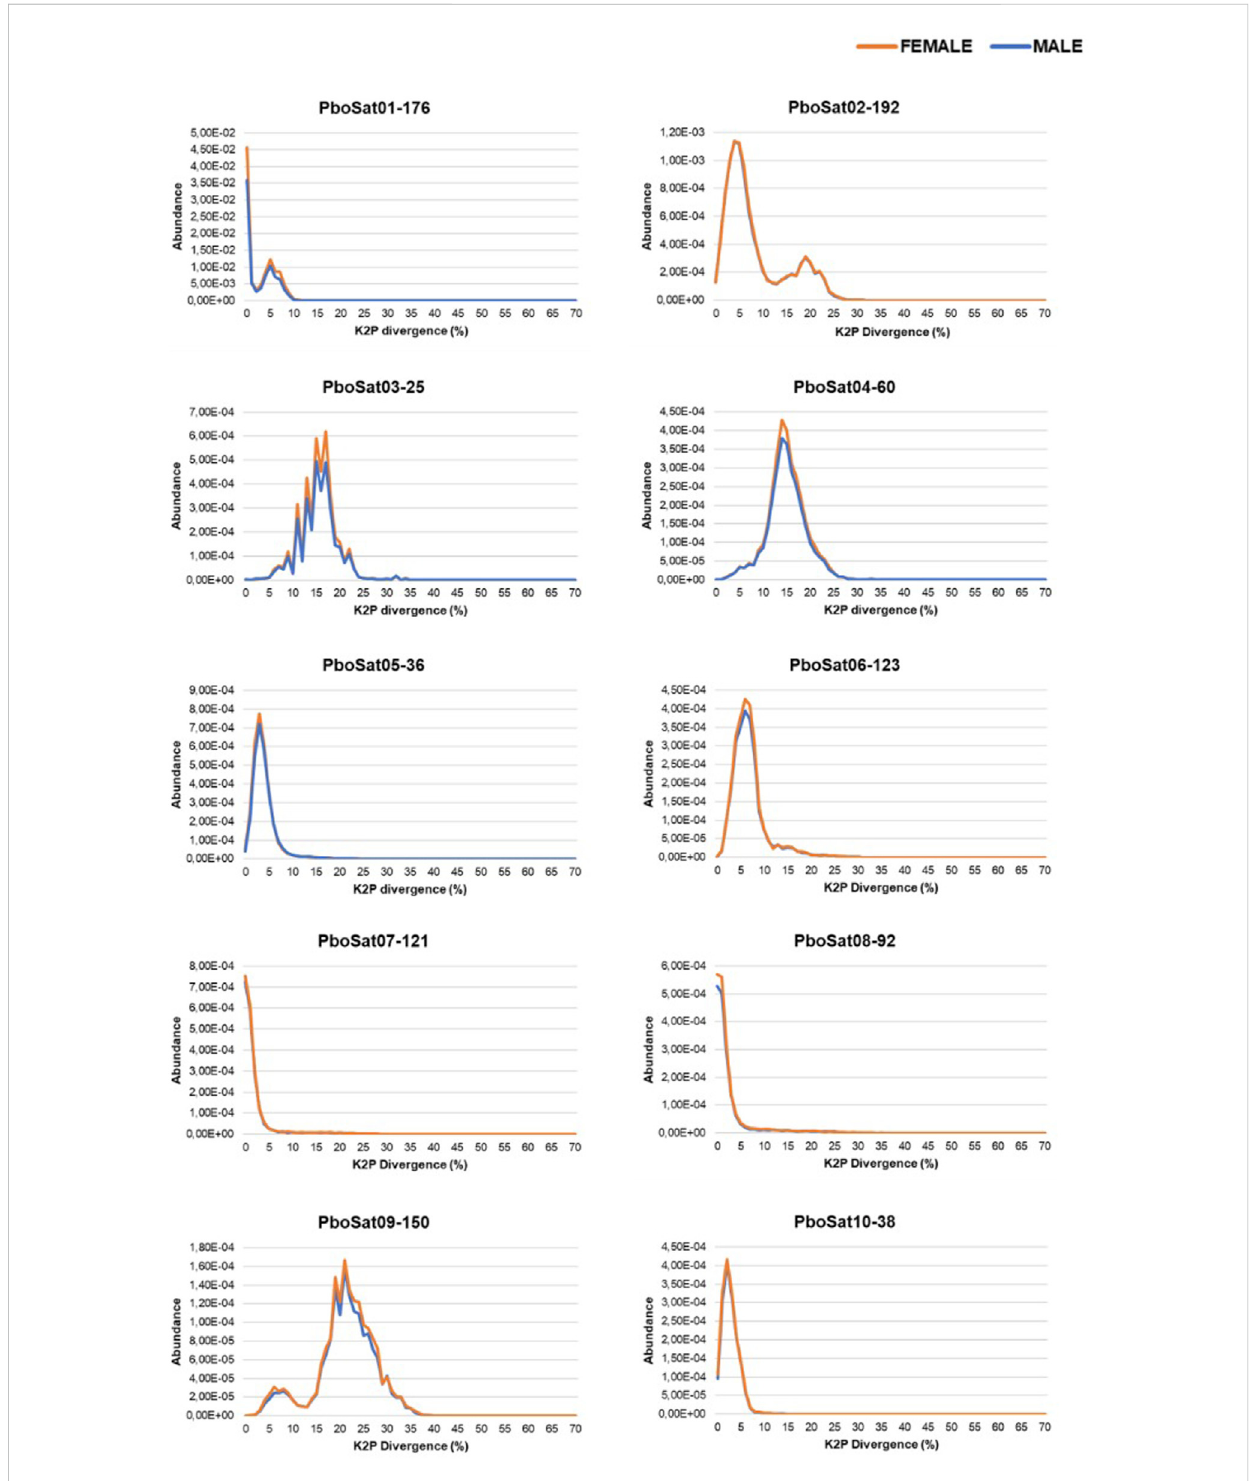
FIGURE 2 Individual satDNA landscapes of male (blue) and female (orange) repeats for ten more abundant satDNAs families identi fi ed in the Proceratophrys boiei